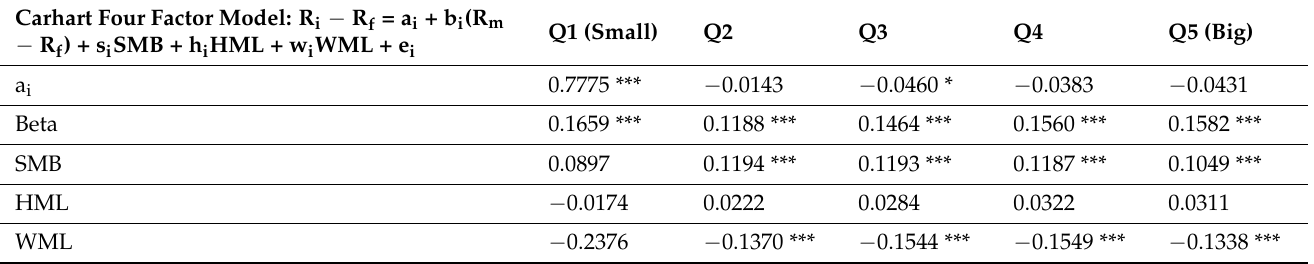
Table 7. Robustness check for Small and Big REIT portfolios (2001–2020).